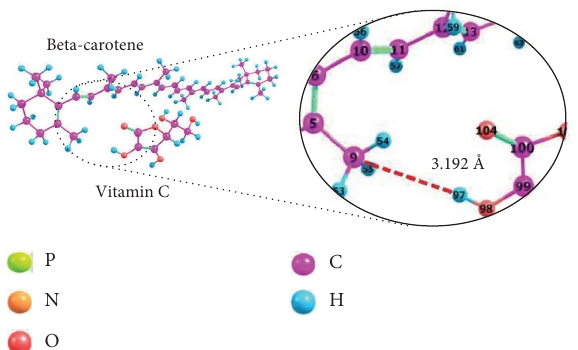
Figure 4: Te interaction of beta-carotene and vitamin C molecules using an optimized structure.